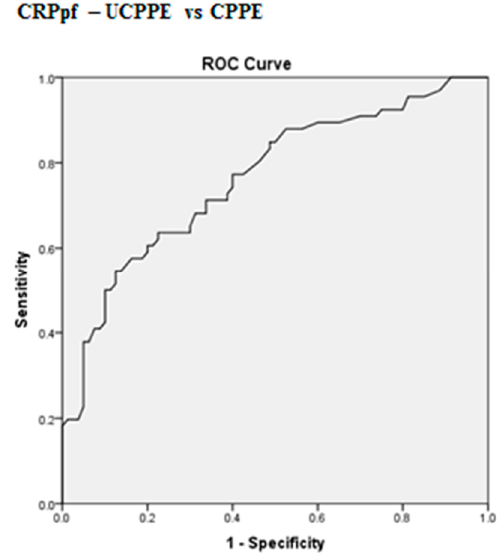
Figure 5. ROC curve of best cut-off value of CRPpf for discrimination between UCPPE and CPPE. CRPpf best cut-off value = 90.5 mg/L, AUC = 76.3% (95% CI: 68.5–84.1), sensitivity = 57.6%, specificity = 83.8%, total accuracy = 72%, PPV = 74.5%, NPV = 70.5%, odds ratio = 6.9 (risk for CPPE when CRPpf value > 90.5 mg/L), p < 0.0001.